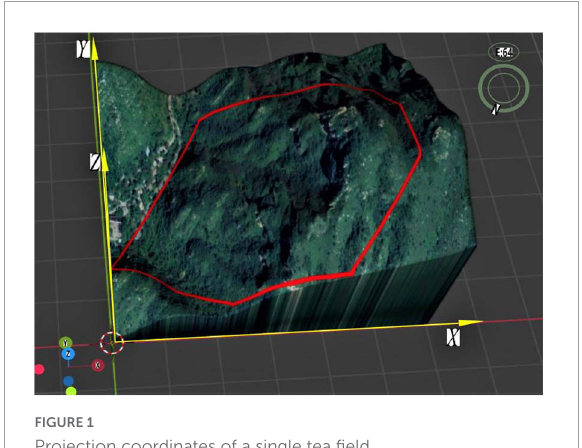
FIGURE1 Projection coordinates of a single tea